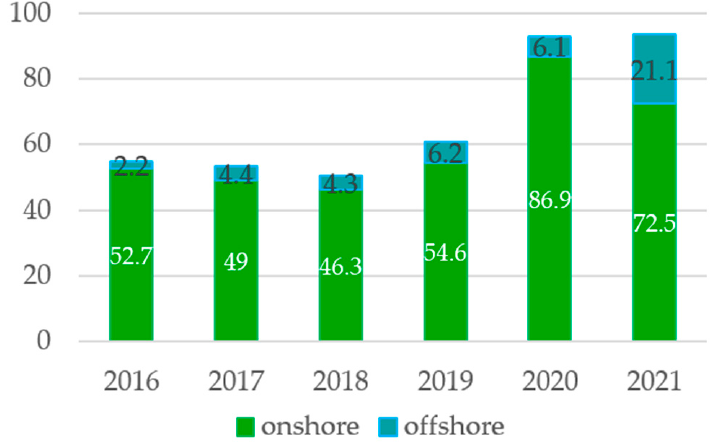
Figure 1. Analysis of installed capacity of wind power.